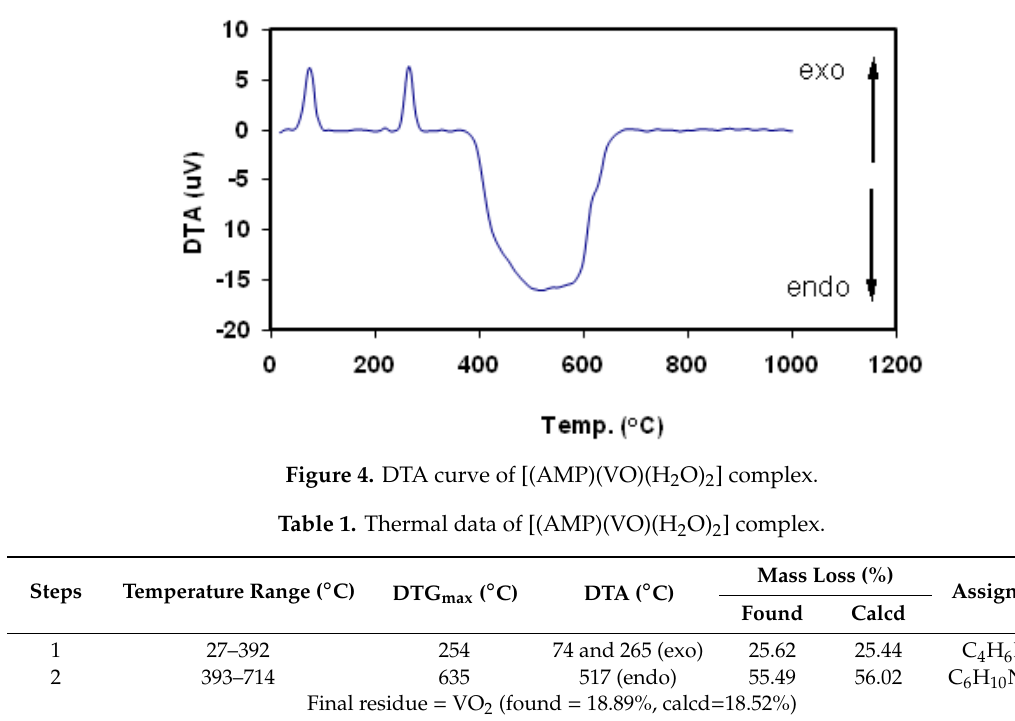
Figure 3. TGA/DTG curves of the [(AMP)(VO)(H 2 O) 2 ] complex.